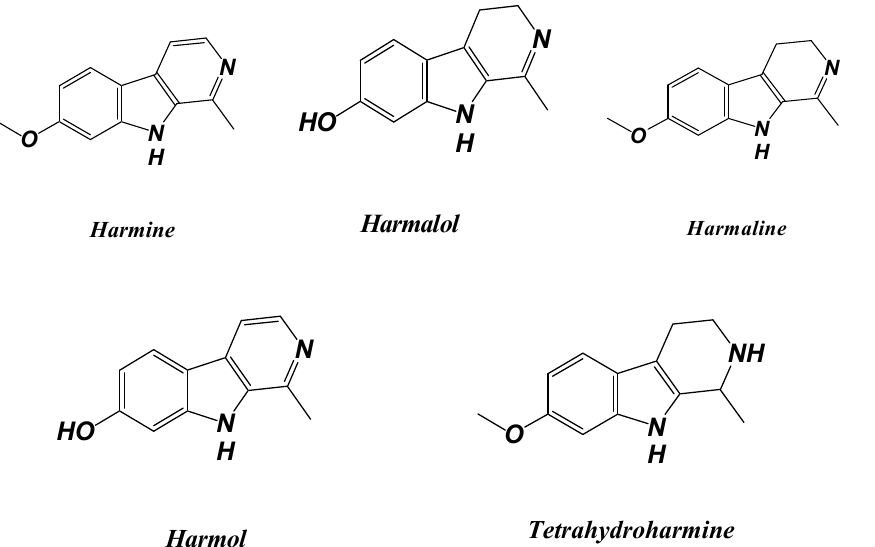
Figure 1. The chemical structure of the major constituents of Harmal extract.